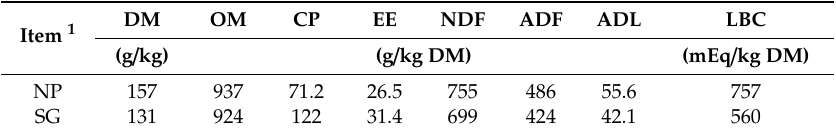
Table 2. Chemical composition and lactate bu ff er capacity of fresh Napier grasses at the late maturity stage used in this study.